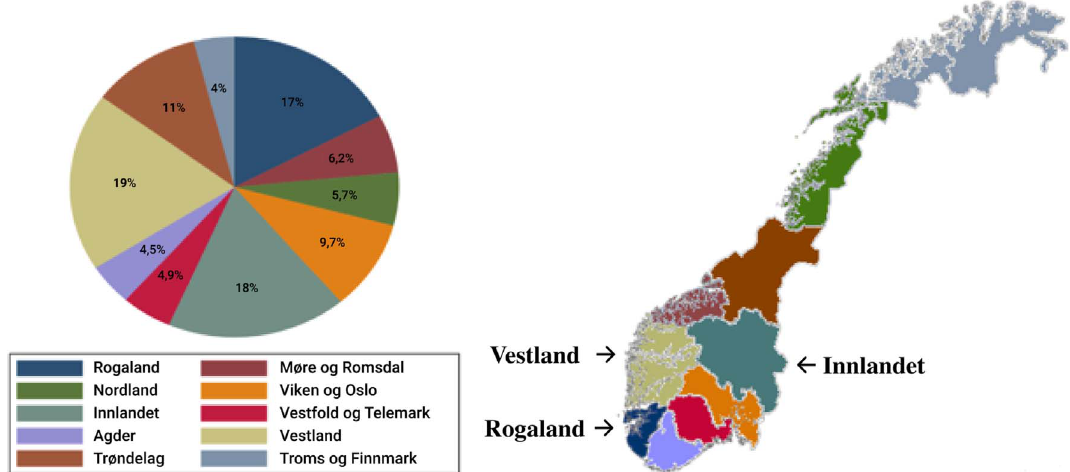
Figure 1. Geographical distribution of respondents displayed by piechart and map of Norway. Oslo and Viken counties are merged, as there was only 1 participant from